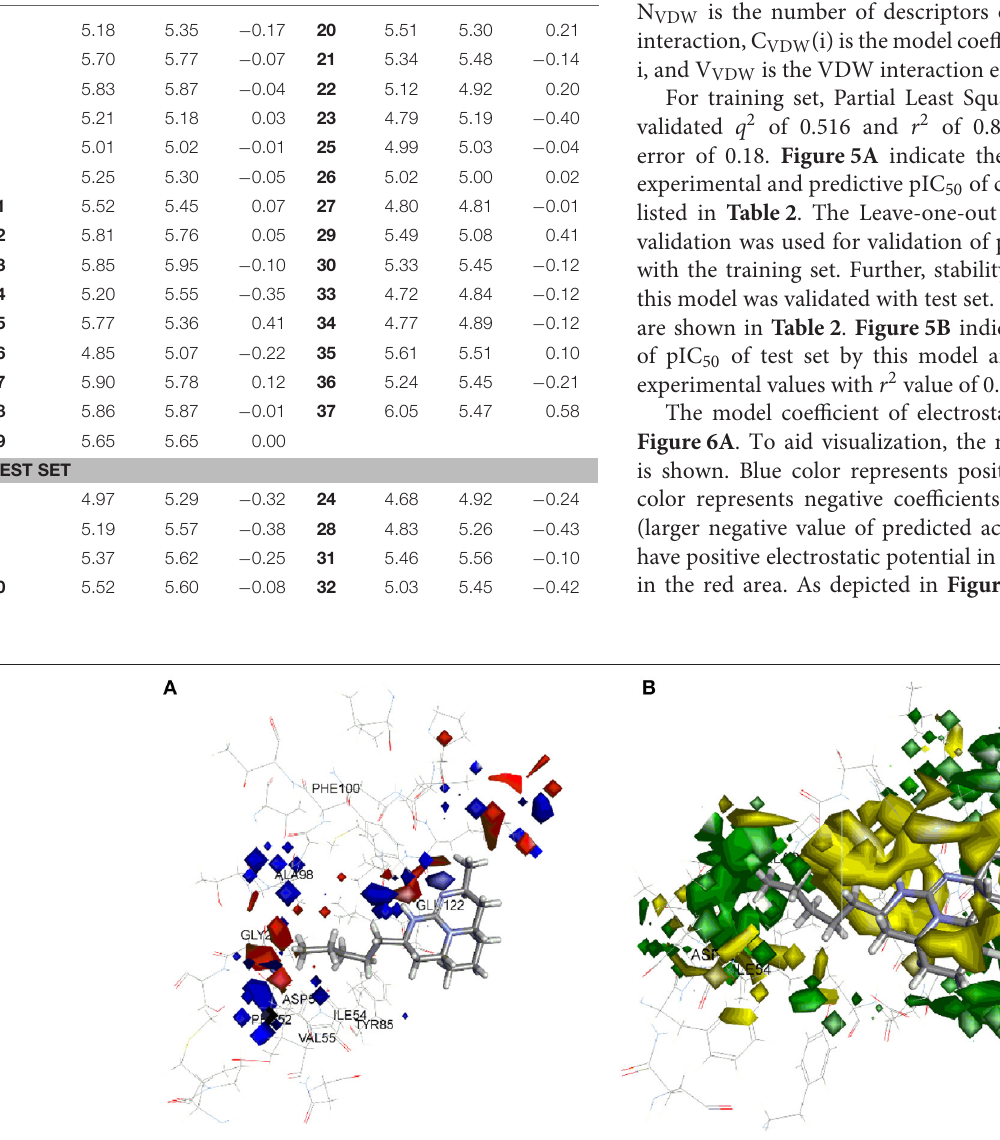
FIGURE 6 | Molecular field analysis contour map displayed with compound 37 and superimposition on active site of Pf LDH (A) electrostatic interaction contour map; blue color represents positive coefficients while red color represents negative coefficients (B) steric interaction contour map; green color indicates positive coefficients and yellow color indicates negative